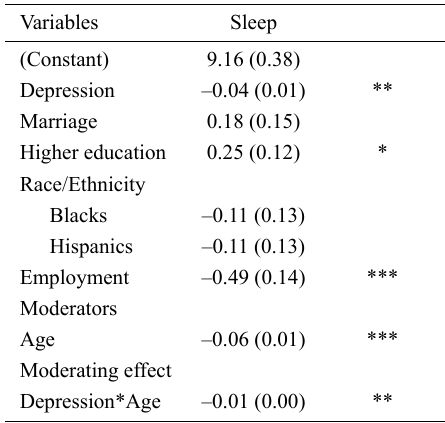
Table 1. Regression results of unstandardized coefficients (standard error) predicting men’s sleep.